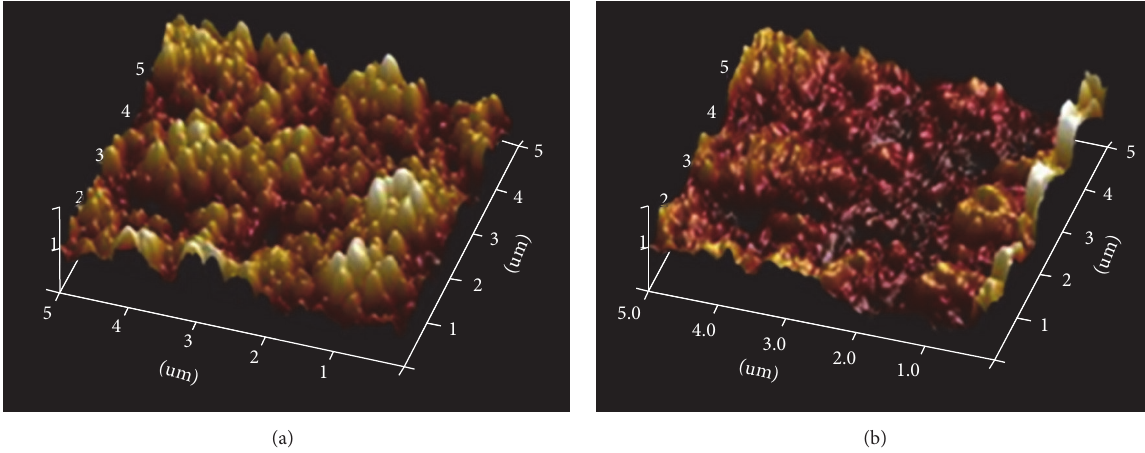
Figure 2: DC biases voltage and AC voltage groups are (a) ( ∼ 10V, 0V) and (b) ( ∼ 10V, − 10 V). Figures 2(a) and 2(b) are the same substrate and the same position.